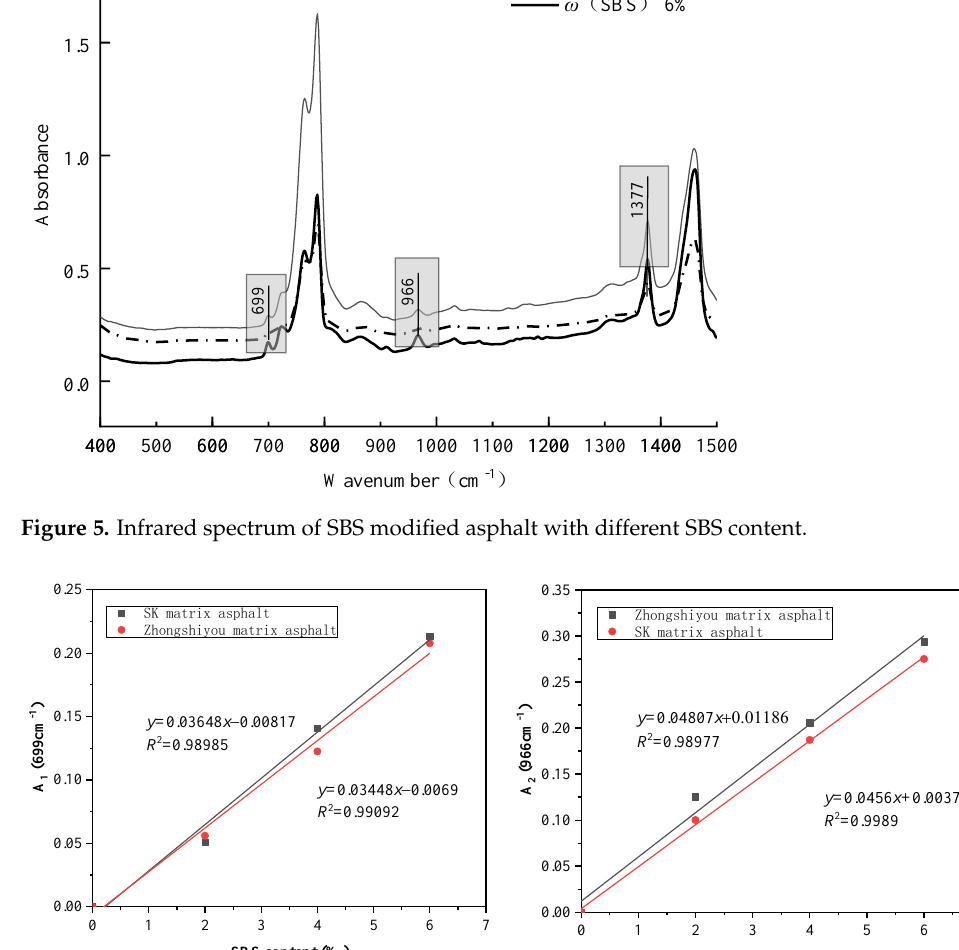
966 cm −1 . ( b ) 966 cm − 1